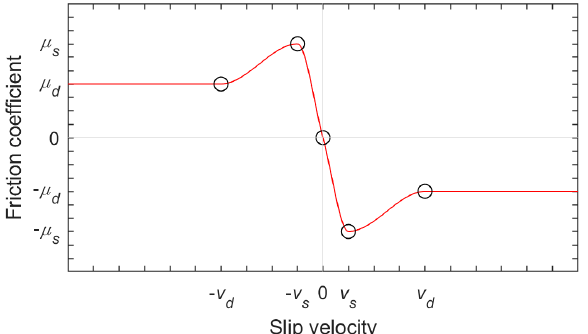
Figure 9. Curve describing the friction model in the tire contacts.